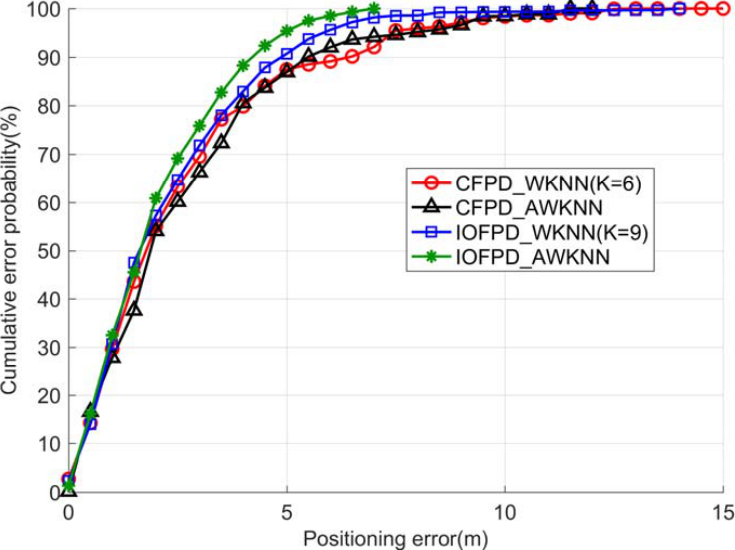
Figure 7. The cumulative probability distributions of the positioning errors related to